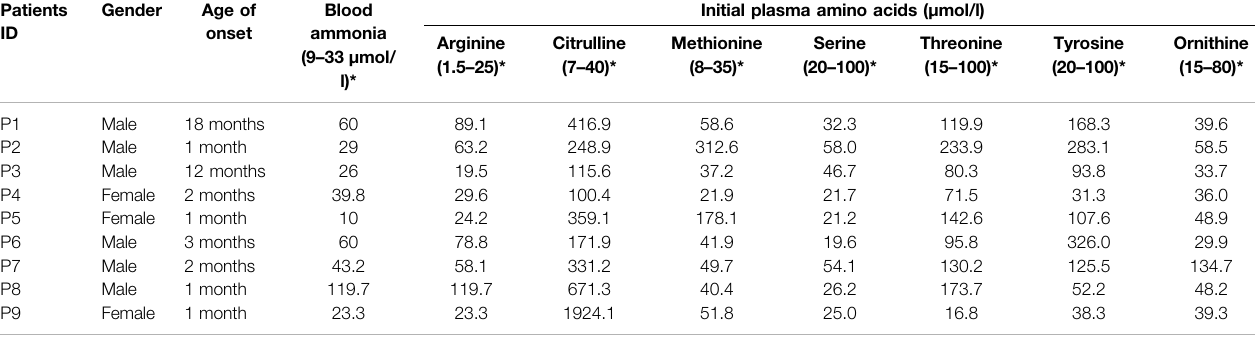
TABLE 1 | Clinical and Biochemical characteristics of patients. Patients